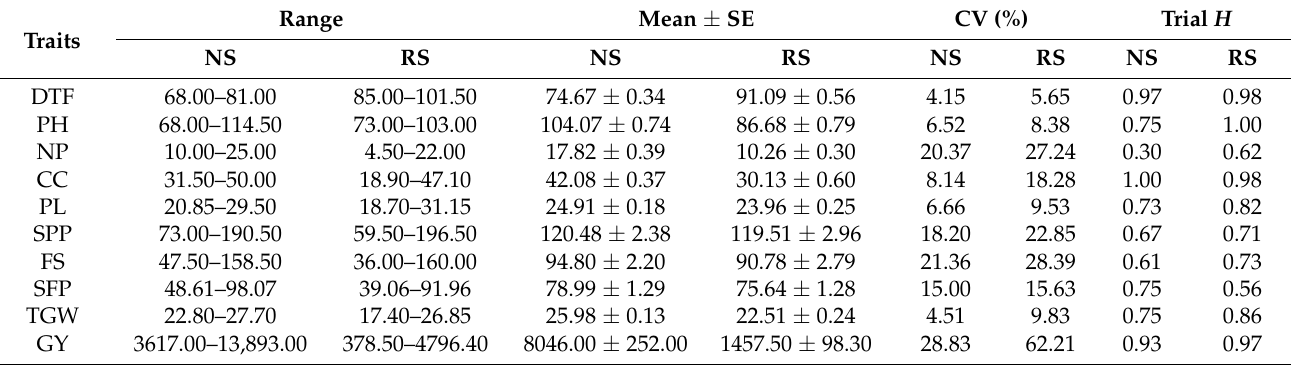
Table 1. Range, mean, coefficient of variation (CV) and broad-sense heritability ( H ) recorded from non-stress (NS) and reproductive stage drought stress (RS) trials of BC 1 F 4 lines. DTF, Days to flowering; PH, plant height; NP, number of panicles; CC, chlorophyll content; PL, panicle length; SPP, number of spikelets per panicle; FS, number of filled spikelets per panicle; SFP, spikelet fertility percentage; TGW, thousand-grain weight; GY, grain yield.